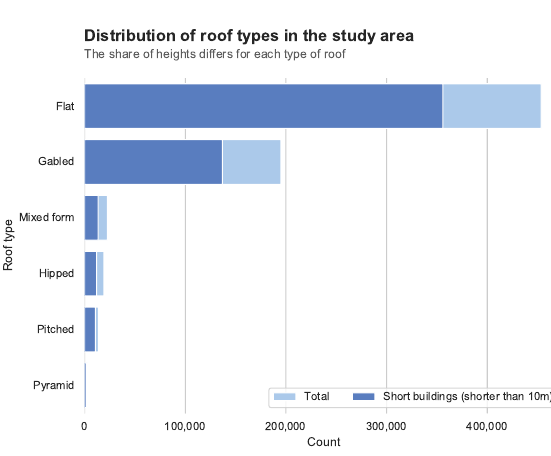
Figure 4. Share of roofs by type in the study area.